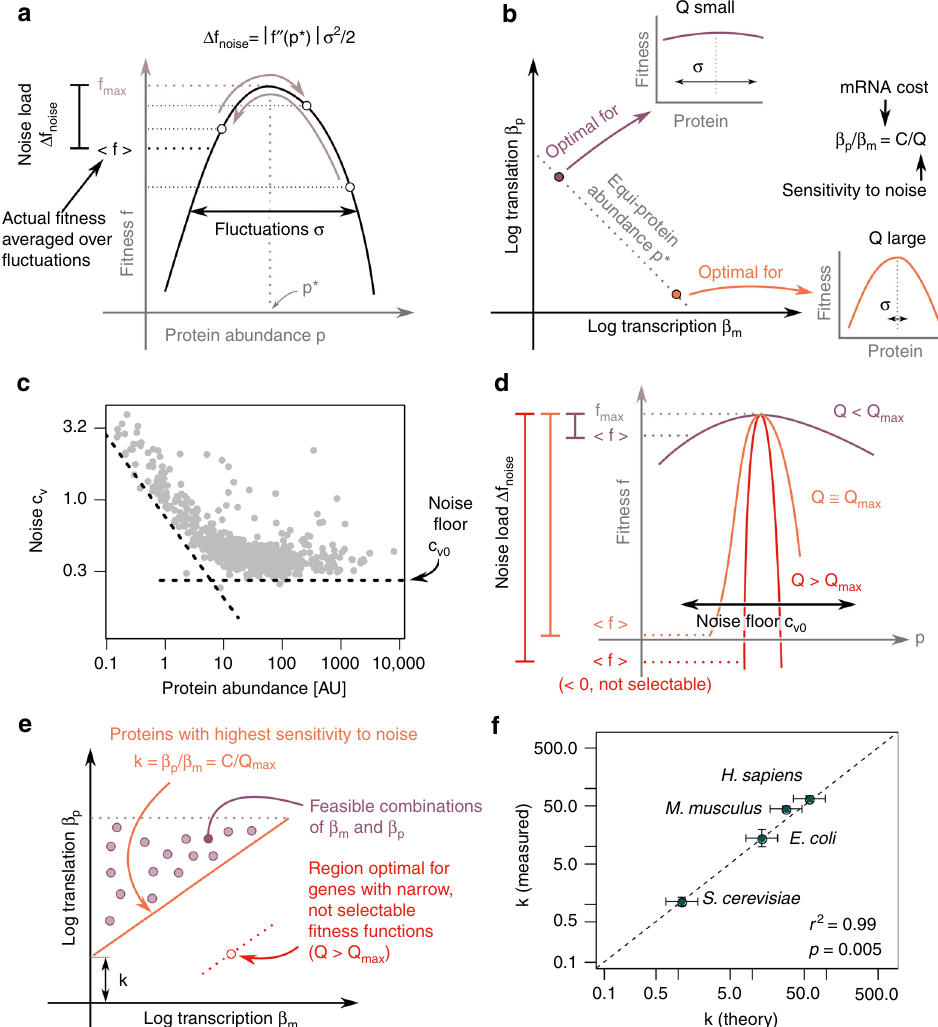
Fig. 4 A trade-off between precision and economy can explain the depletion of genes combining high transcription with low translation. a The noise load Δ f fi tness due to stochastic fl uctuations in protein abundance. b The optimal β p / β m depends on the transcription cost per mRNA ( C ) and noise is the loss of on how noise sensitive ( Q ~ | f ′′ ( p * )|) the gene is. Noise-sensitive genes have narrower fi tness functions (| f ′′ ( p * )| large). For a given p * , higher transcription β m decreases fl uctuations in protein abundance. Genes that are sensitive to noise ( Q large) should thus have low translation/transcription ratio. On the other hand, precision is less critical for genes with fl at fi tness functions ( Q small). These genes should have higher β p / β m to keep transcription costs low. c The precision of gene expression is limited by the noise fl oor c v 0 . Protein abundance and CV data re-plotted from Taniguchi et al. 40 . The noise fl oor is also found in the E. coli measurements of Silander et al. 41 (Supplementary Fig. 4b). d Genes with fi tness functions narrower than the noise fl oor c v 0 have negative average fi tness f h i < 0 ð Þ . Genes with negative fi tness are not selectable. Thus, the noise fl oor c v 0 prevents the selection of narrow, noise-sensitive fi tness functions. e The maximal, selectable noise sensitivity Q k of the boundary of the depleted region. Proteins lying on the max determines the position boundary have maximal noise sensitivity Q = Q max . Feasible combinations of transcription and translation correspond to genes that are less sensitive to noise Q < Q max . f The precision-economy trade-off theory predicts the position k of the depleted region in organisms from bacteria to mammals. Error bars represent 95% con fi dence intervals. The p -value is computed using Pearson ’ s test on 4 organisms (two-sided). The correlation between measurements and theory is robust to varying the fraction of genes used in de fi ning the depleted region (Supplementary Fig. 4e). See also Supplementary Fig. 4 NATURE COMMUNICATIONS| (2019) 10:68